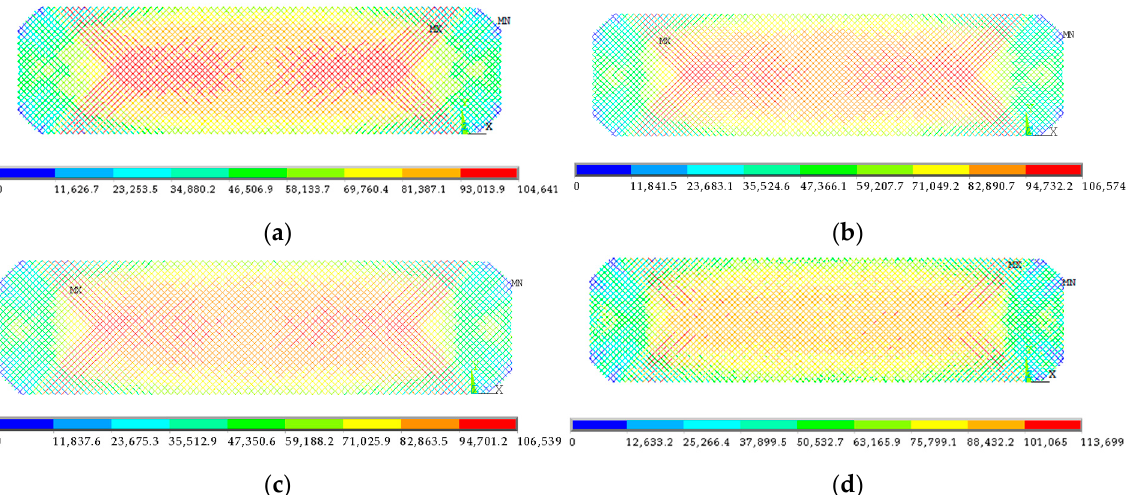
Figure 6. Cloud chart of cable net axial force (unit: N): ( a ) μ = 0.2; ( b ) μ = 0.44; ( c ) μ = 0.68; and ( d ) μ = μ = ∞ *.